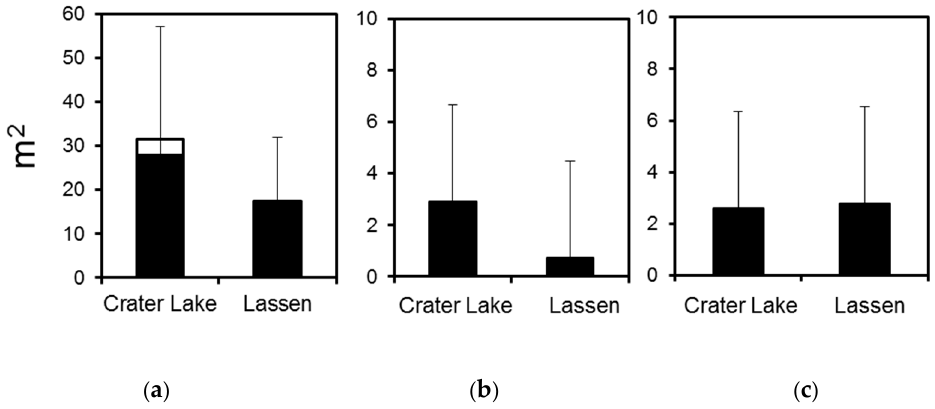
Figure 7. Basal area (m 2 ) statistics from 30 whitebark pine plots in Crater Lake and Lassen Volcanic National Parks. Means and SD are shown. ( a ) Basal area of all other trees. Black bars represent living trees and white bars represent dead trees, ( b ) Basal area of dead whitebark pine, ( c ) Basal area of live whitebark pine. Table 3. Summary statistics of unstandardized covariates included in each of the five generalized linear mixed-effects models in both Crater Lake (CRLA) and Lassen Volcanic (LAVO) National Parks. The values below represent averages and standard deviations for each covariate across all plots ( n = 30) in each park.